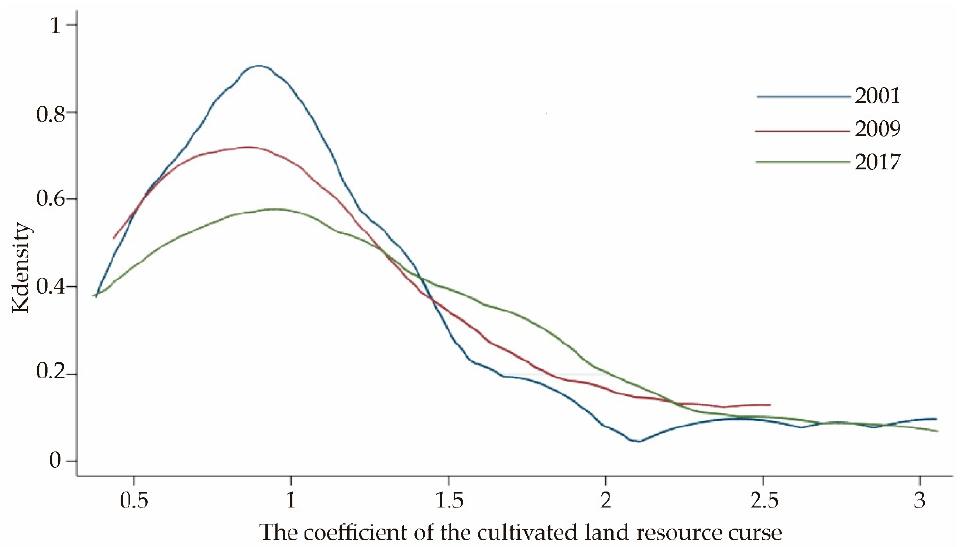
Figure 4. Kernel density distribution of the cultivated land resource curse coefficients for the county-level administrative regions in Jianghan Plain.